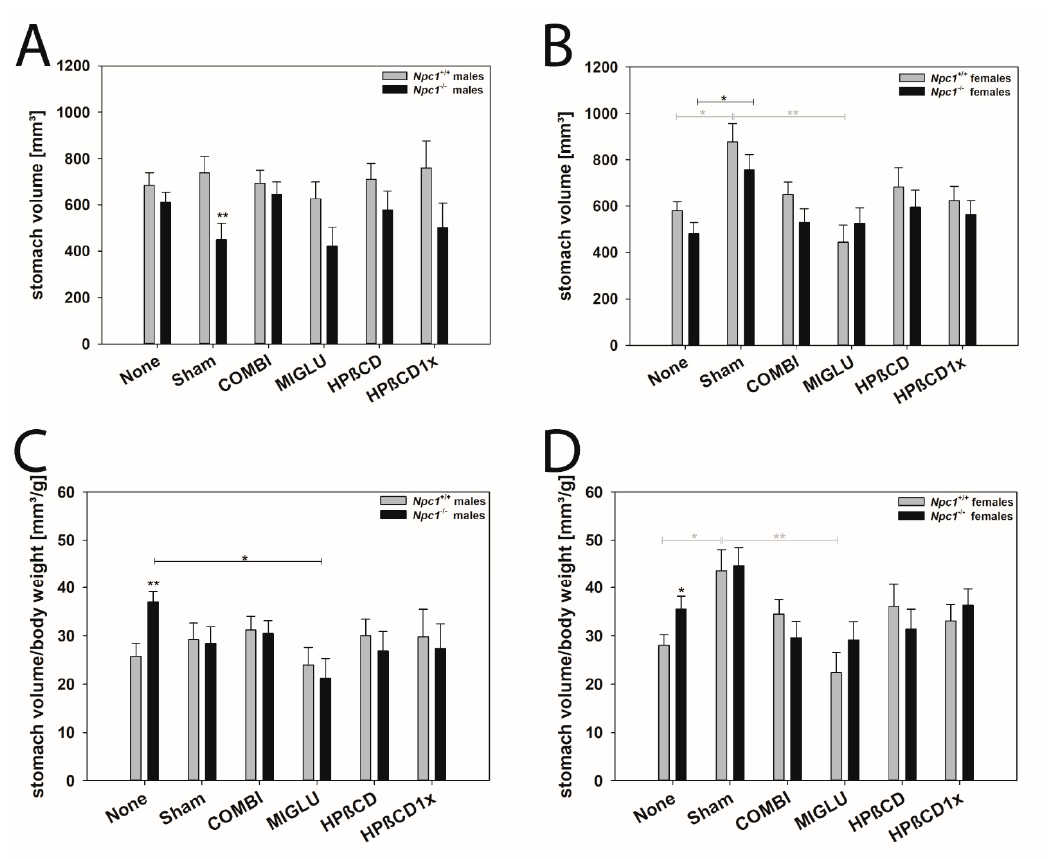
Figure 13. Stomach volume ( A , B ) and relative stomach volume ( C , D ) of Npc1 mice. Male ( A , C ) and female ( B , D ) mice. Significant post-hoc tests are indicated by asterisks (* p < 0.05, ** p < 0.01). Data are means ± SEM.